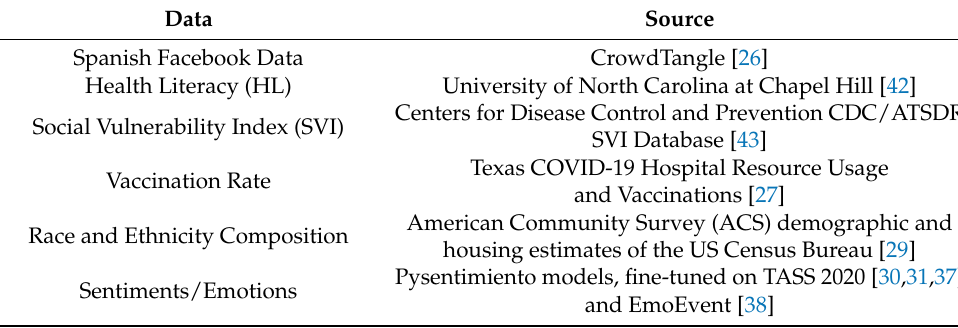
Table 2. All data and their sources used in the study.